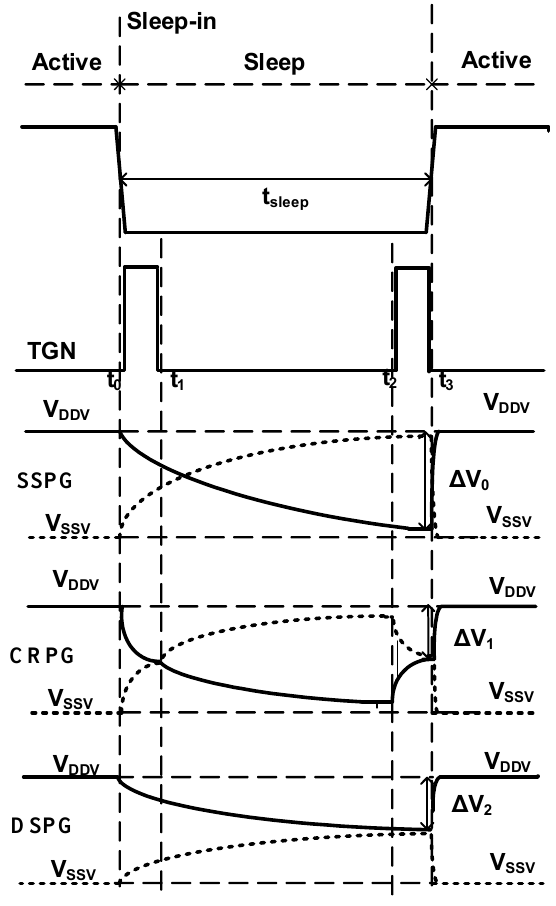
Figure 2. Waveforms of the SSPG, CRPG, and DSPG when a sleep time is